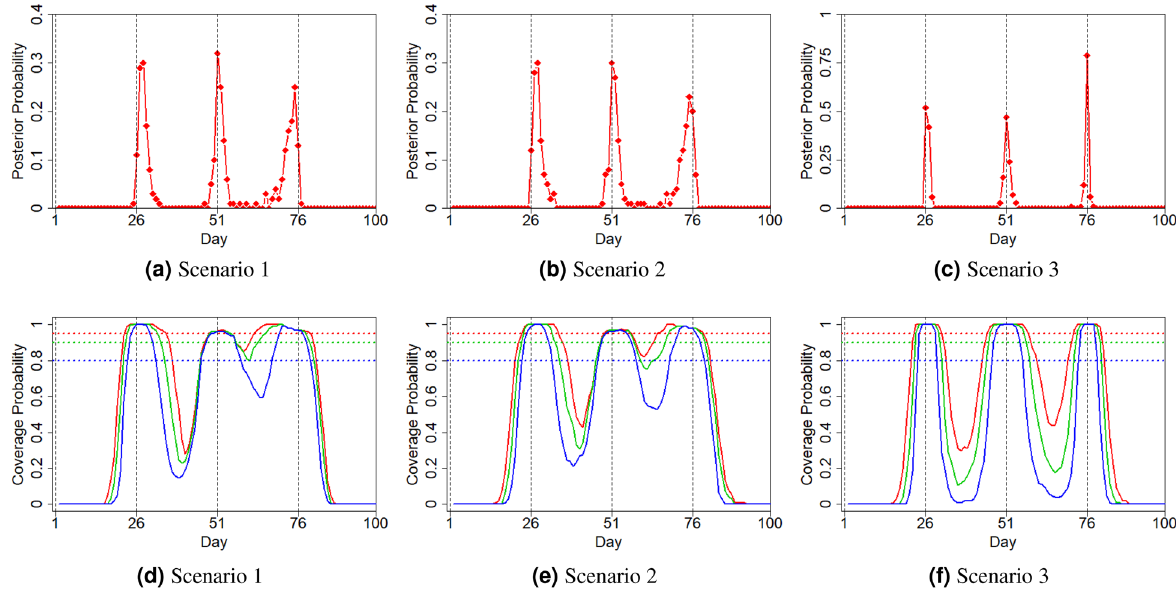
Figure 4. ( a – c ) Proportions that a change point is estimated at time t ( 1 ≤ t ≤ T ) under different scenarios; ( d – f ) Coverage probability of the ( 1 − α) HPD intervals of change points at each t under different scenarios ( 1 − α = 95% in red; 90% in green; 80% in